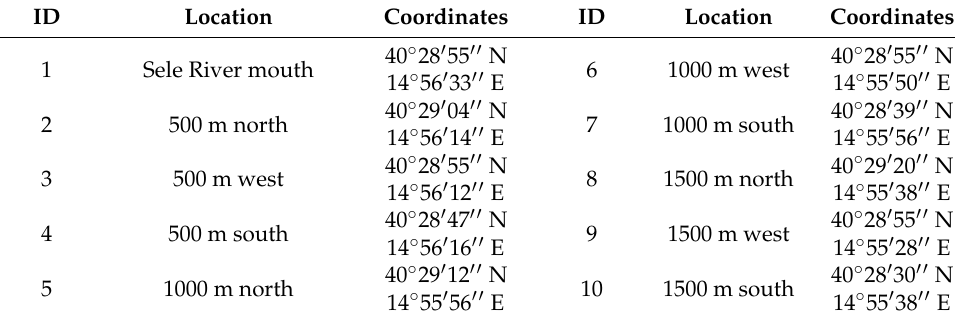
Figure 2. Hydrographic network and sampling sites near the Sele River. Table 1. Sampling sites with their identification number (ID), location name, and coordinates from the Sele River.